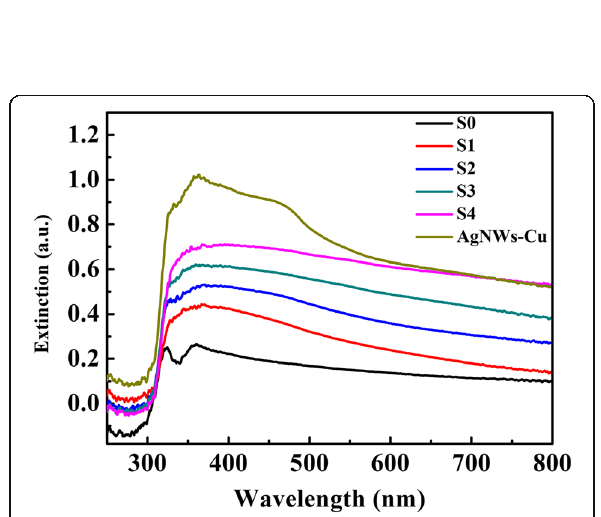
Fig. 7 UV – vis extinction spectra of aligned Ag nanowire substrate (AgNWs), the Cu-decorated AgNWs film (AgNWs-Cu), and different silver nanoparticles decorated aligned silver nanowires films with different copper coating, the composite films were labeled as AgNWs@AgNPs-1, 2, 3, 4